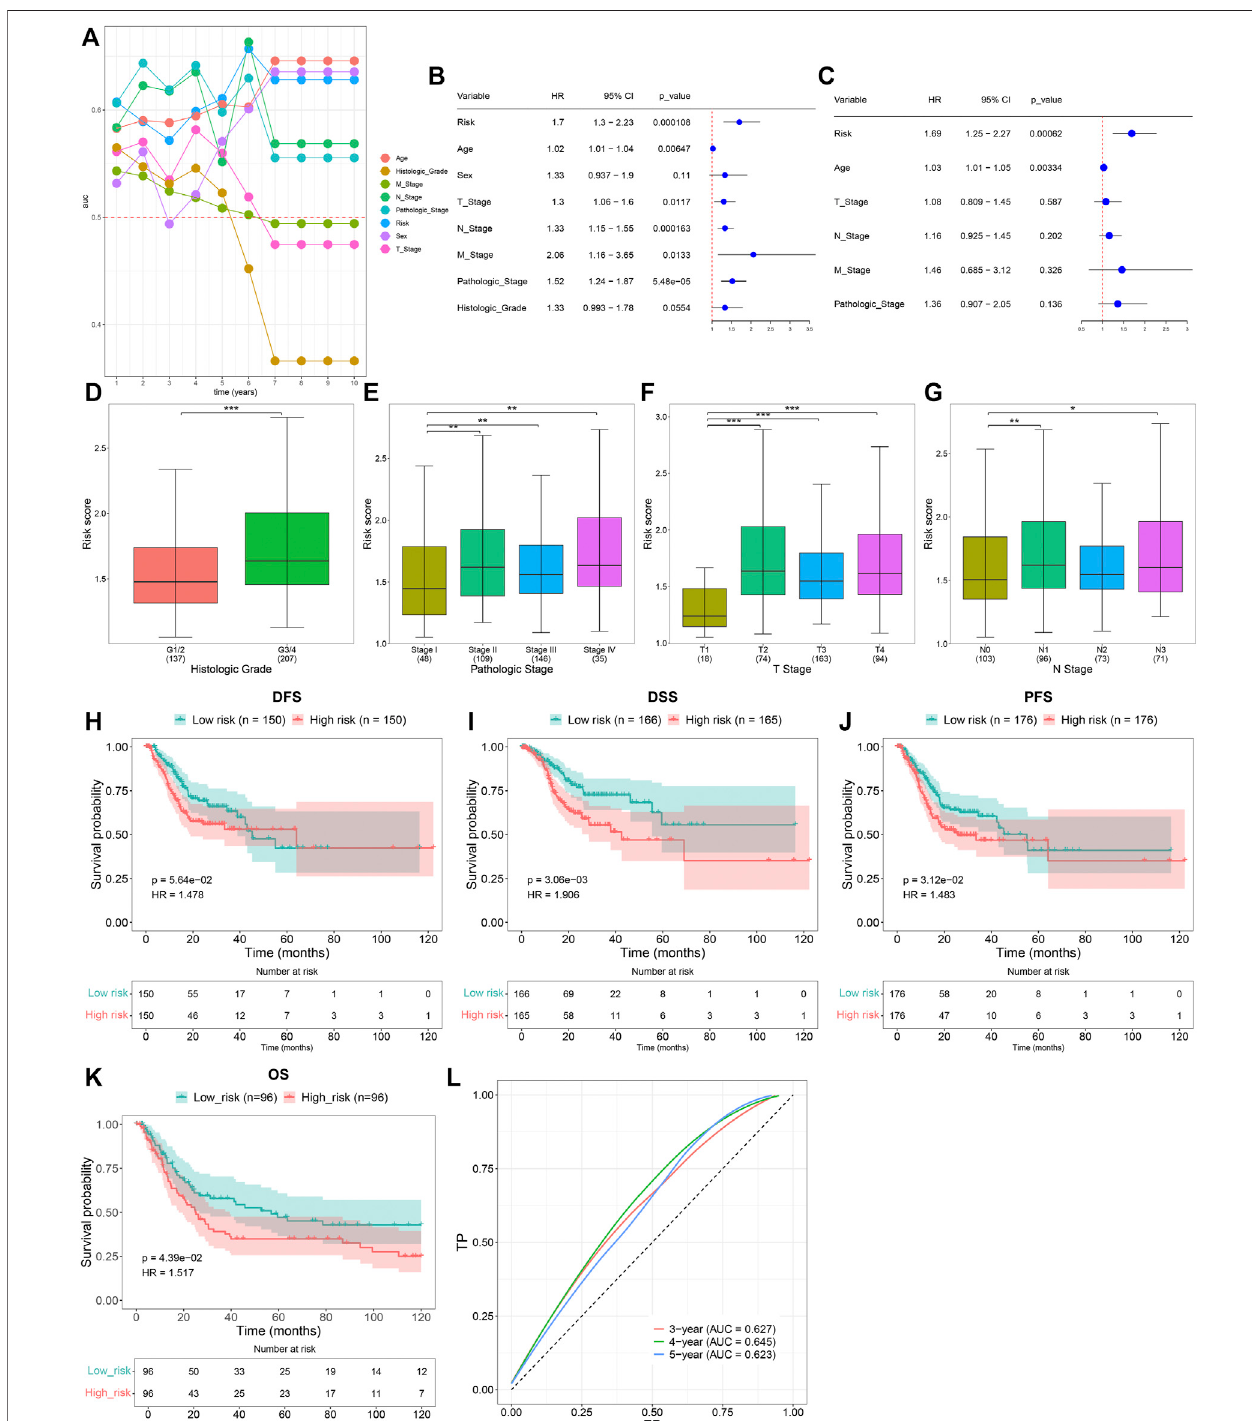
FIGURE 3 | Clinical implication of the TNF α -derived gene signature in GC. (A) Time-independent ROC curves of the TNF α -derived risk score and conventional clinicopathological characteristics. (B) Univariate Cox regression analyses for the associations of the TNF α -derived risk score and conventional clinicopathological characteristics with GC prognosis. (C) Multivariate Cox regression analyses for evaluations of the predictive independency of the aforementioned factors in GC prognosis. (D – G) Distribution of the TNF α -derived risk score in distinct clinicopathological characteristics, containing the (D) histological grade, (E) pathological stage, (F) Tstage,and (G) Nstage.* p < 0.05;** p < 0.01;*** p < 0.001. (H – J) Kaplan – Meiercurvesof (H) DFS, (I) DSS,and (J) PFSforhigh-andlow-riskGCpatients. (K) Kaplan – Meier curves of OS for high- and low-risk GC patients in the GSE15459 dataset. (L) ROCs at 3-, 4-, and 5-year survival in the GSE15459 dataset.